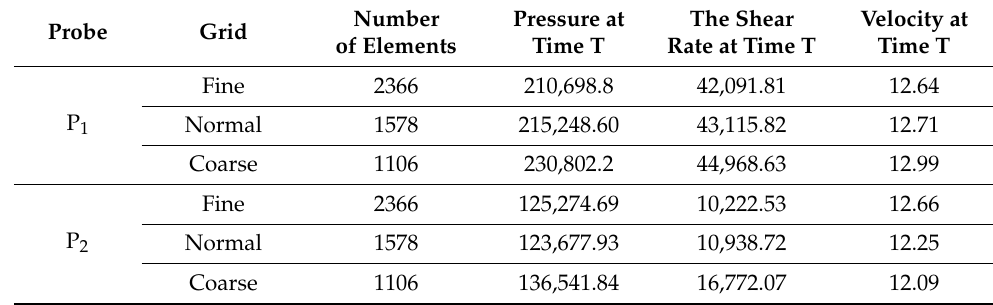
Table 5. Grid convergence index for different variables. Variable